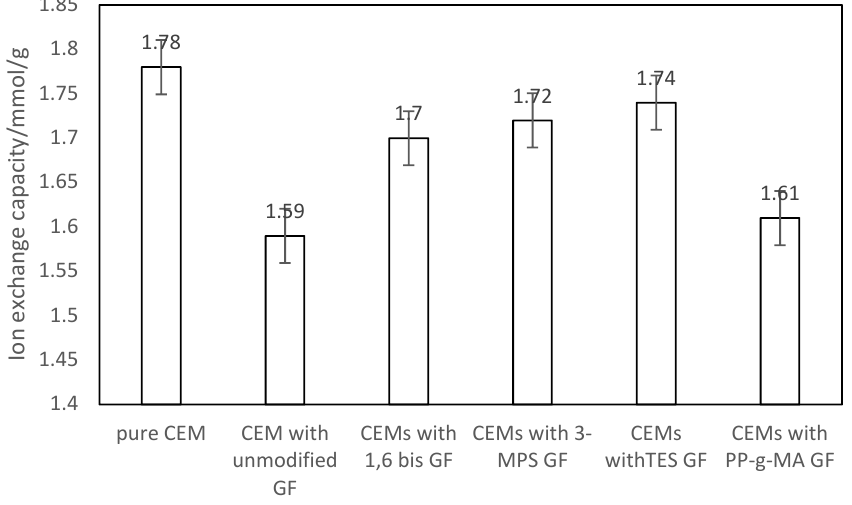
Figure 13. E ff ect of GF with di ff erent coupling agents on ion exchange capacity (IEC) of Figure 13. Effect of GF with different coupling agents on ion exchange capacity (IEC) of CEMs.